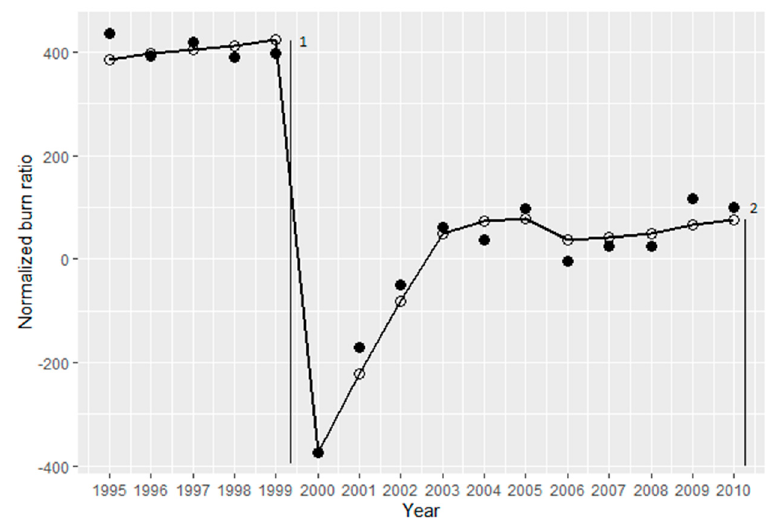
Figure 2. A conceptual example of Landsat-based Detection of Trends in Disturbance and Recovery (LandTrendr) fitting the normalized burn ratio (NBR) values to the spectral-temporal segments of a pixel burned at a high severity level in the 1999 Fire. The original NBRs are displayed by black circles, and the fitted are displayed by open circles. The percent of the NBR change in 2010 was defined as distance 2 divided by distance 1 multiplied by